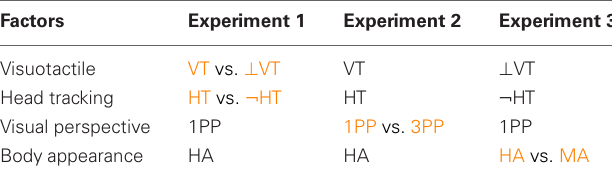
FIGURE 1 | Perspective levels and body appearances levels used for the different conditions of the experiments. Gender-matched avatars were assigned to each participant. [A,B (D,E)] Show the two levels of the factor “perspective” for a female (male) participant: in the 1PP conditions (A,D,C,F) when looking down participants could see a virtual body co-located with their own physical body, while in the 3PP conditions (B,E)